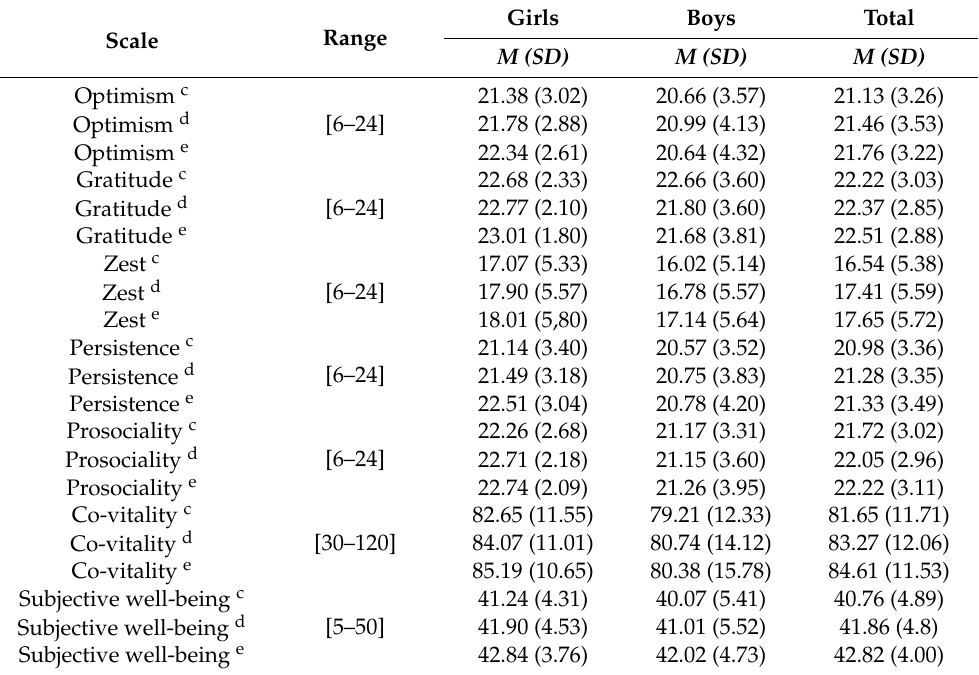
Table 2. Descriptive statistics of levels of subjective well-being and social-emotional competencies from the pre-test, post-test, and follow-up a, b